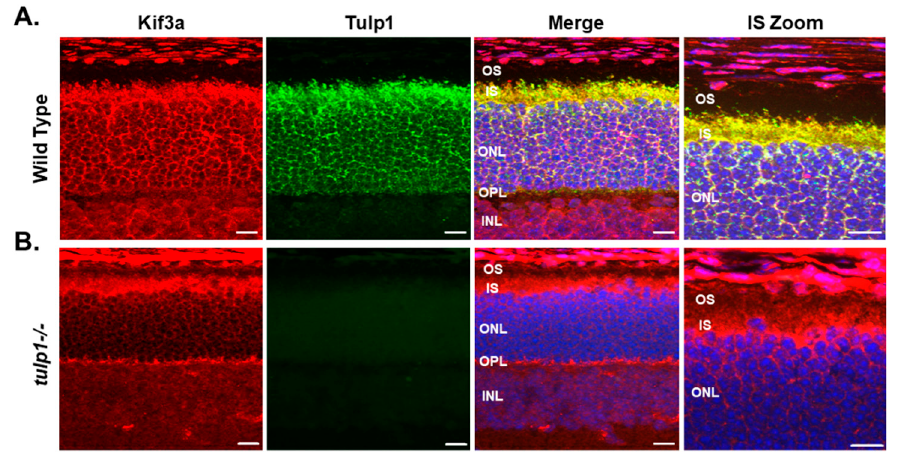
Figure 5. Immunolocalization of Kif3a and Tulp1 in P17 mouse retinas. ( A ) Wt retinal sections stained with Kif3a (red) and Tulp1 (green). ( B ) Tulp1 − / − retinal sections stained with Kif3a (red) and Tulp1 (green). Sections were counterstained with DAPI (blue). Scale bar: 50 μ m. INL, inner nuclear layer; OPL, outer plexiform layer; ONL, outer nuclear layer; IS, inner segment layer; OS, outer segment layer.